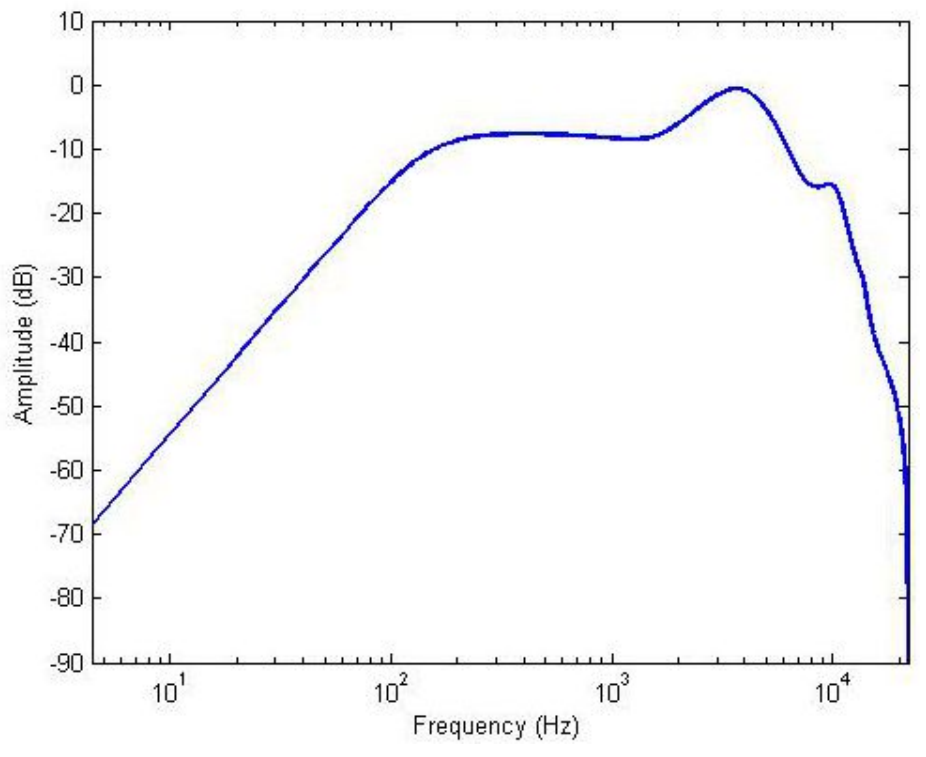
Figure 2. Amplitude frequency response of equal loudness